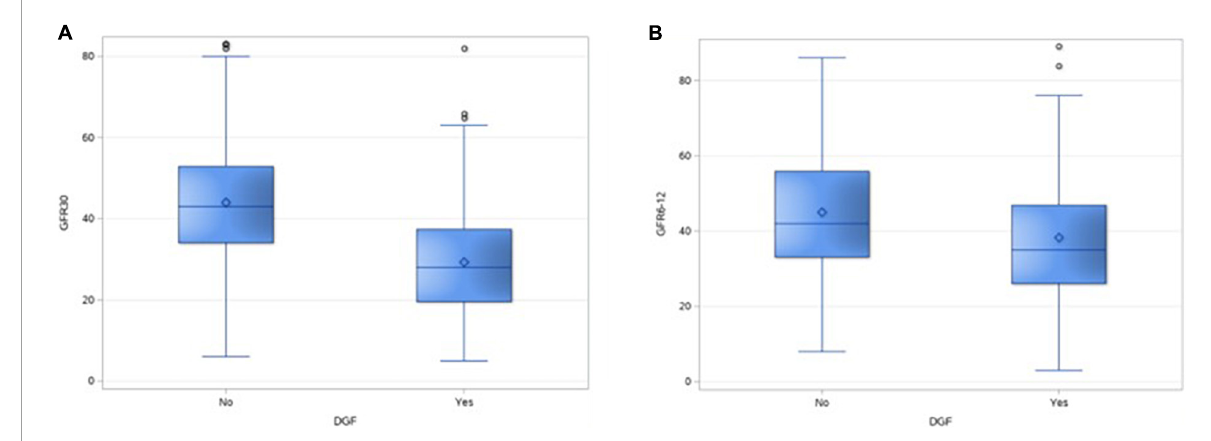
FIGURE3 Box and whisker plot showing the distribution of GFR of 30 days (A) and at 1 year (B) in the two